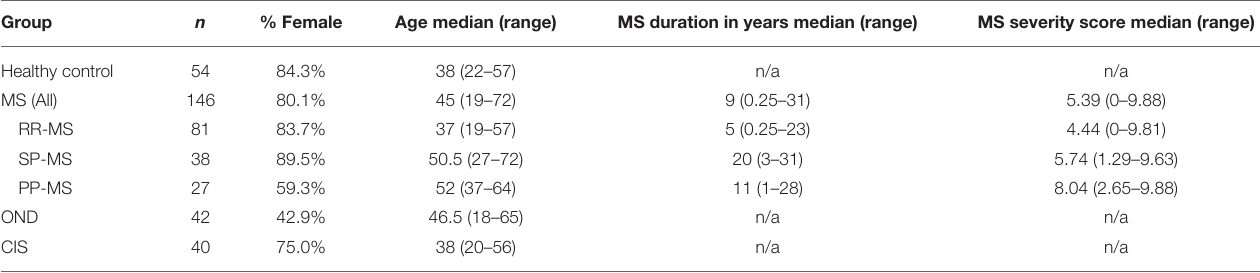
TABLE 1 | Demographics of patients and